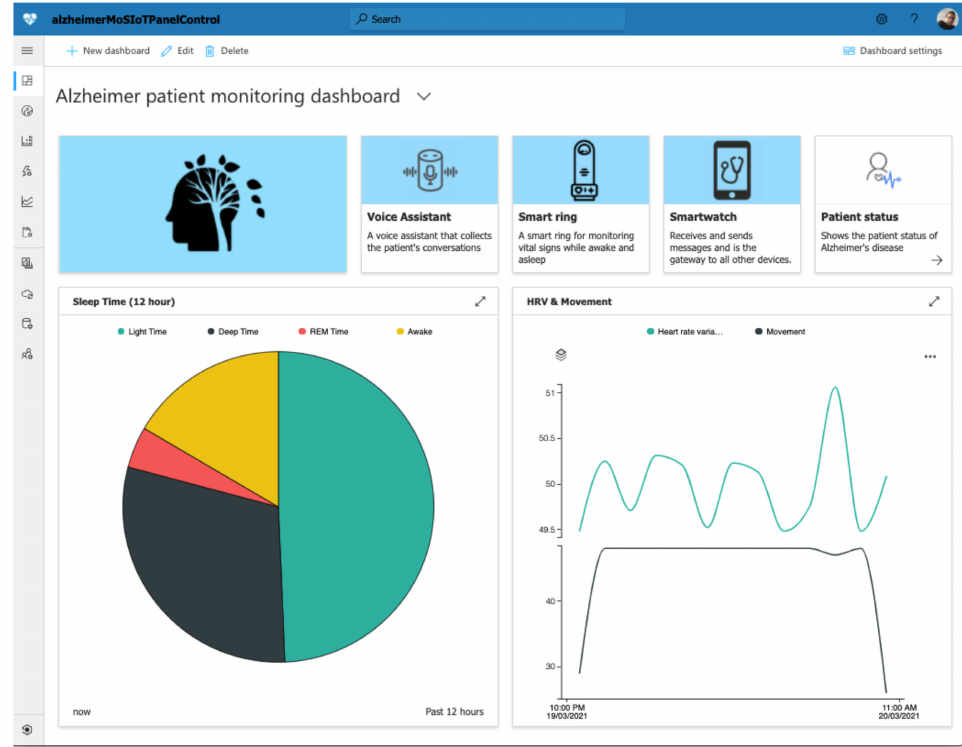
Figure 14. An excerpt of the dashboard for the Alzheimer’s